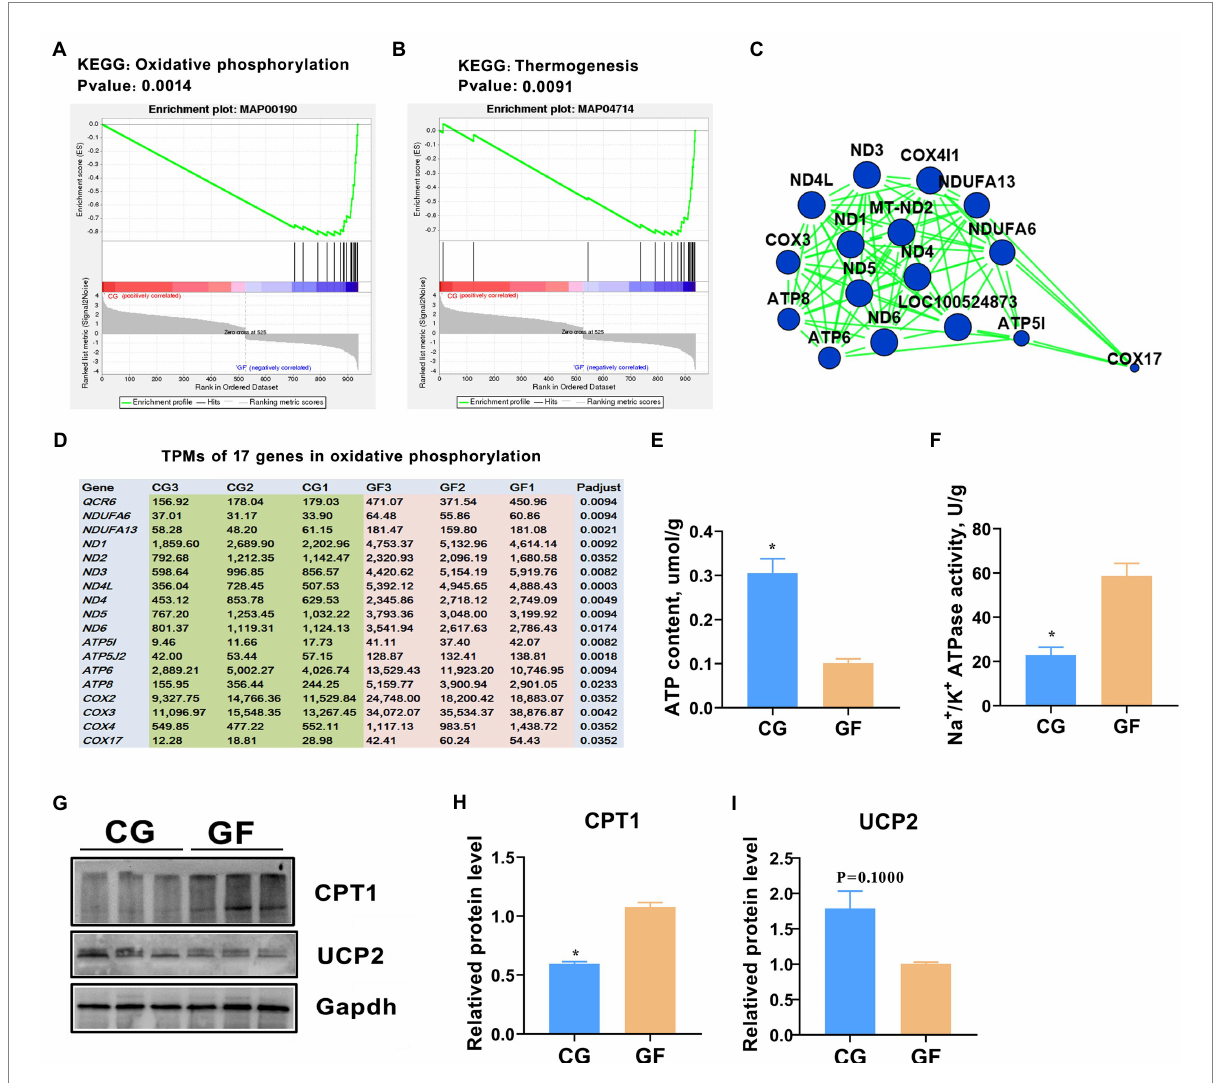
FIGURE 8 Hypothalamic energy consumption in pigs. GSEA analysis showed that oxidative phosphorylation (A) and thermogenesis (B) were significantly changed in GF pigs. (C) Protein–protein interaction (PPI) network of the 17 changed genes involved in oxidative phosphorylation and thermogenesis. (D) Expression levels (TPMs) of the 17 genes related to oxidative phosphorylation and thermogenesis. (E) ATP contents in the hypothalamus; (F) ATPase activity in the hypothalamus. (G) Western blotting (WB) analysis the protein levels of carnitine palmitoyl transterase-1 (CPT1) and uncoupling protein 2 (UCP2) in hypothalamus. (H,I) Quantitative analysis of the protein levels of CPT 1 and UCP2. The data are presented as the means ± SEM. *indicates p < 0.05 between CG pigs and GF pigs, n = 4 for the ATP content and ATPase activity assay and n = 3 for WB